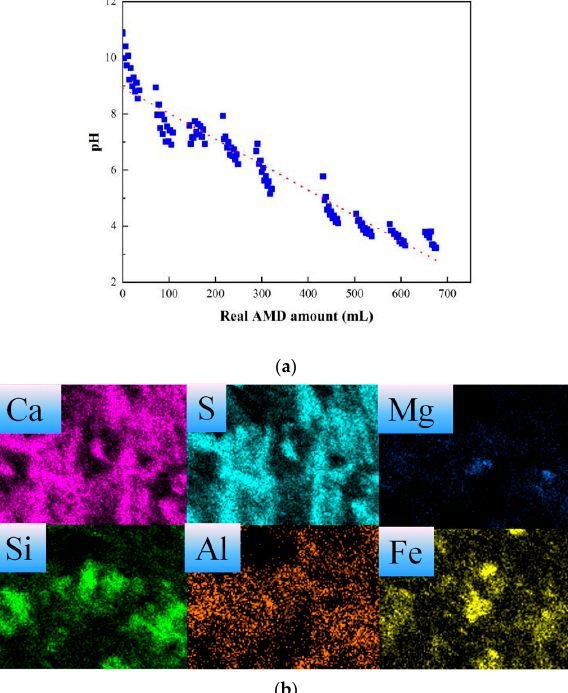
Figure 8. Experimental results for steel slags neutralized by real AMD, ( a ) pH variation, ( b ) element distribution on steel slag surface. distribution on steel slag